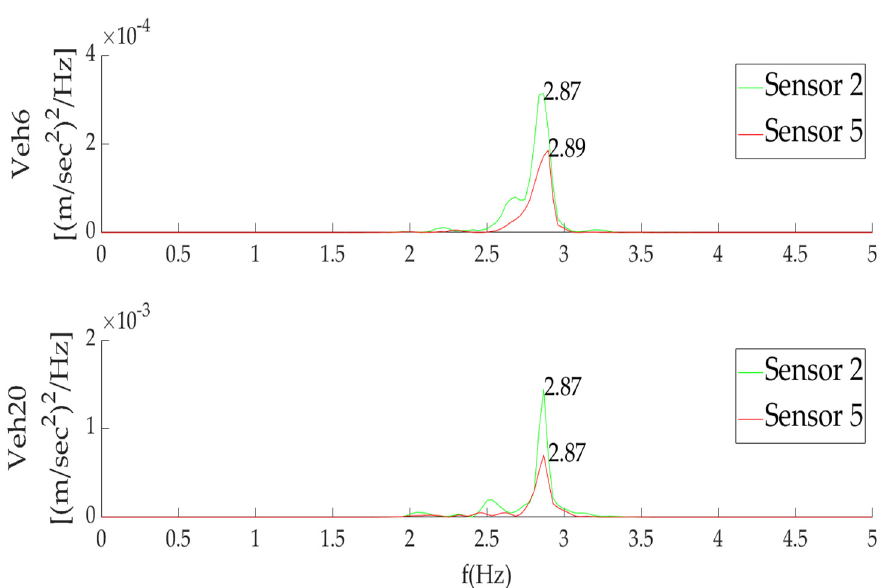
Figure 12. Single Side Power Spectral Density for the free vibration time histories of Veh6 and Veh20. Table 10. Estimated damping ratios based on free vibration time